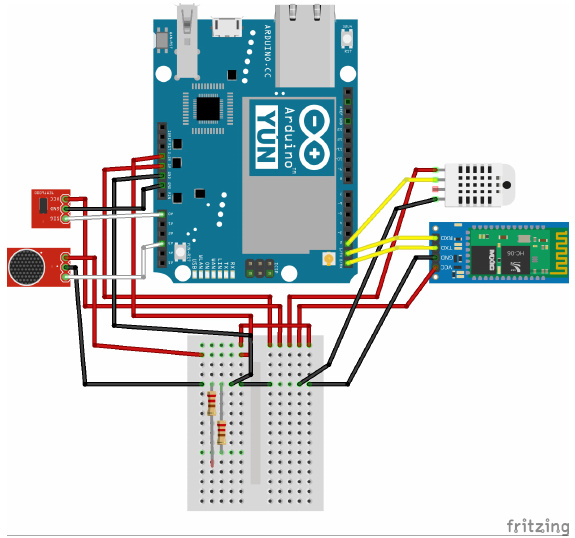
Figure 1. Sensor Circuit schema.